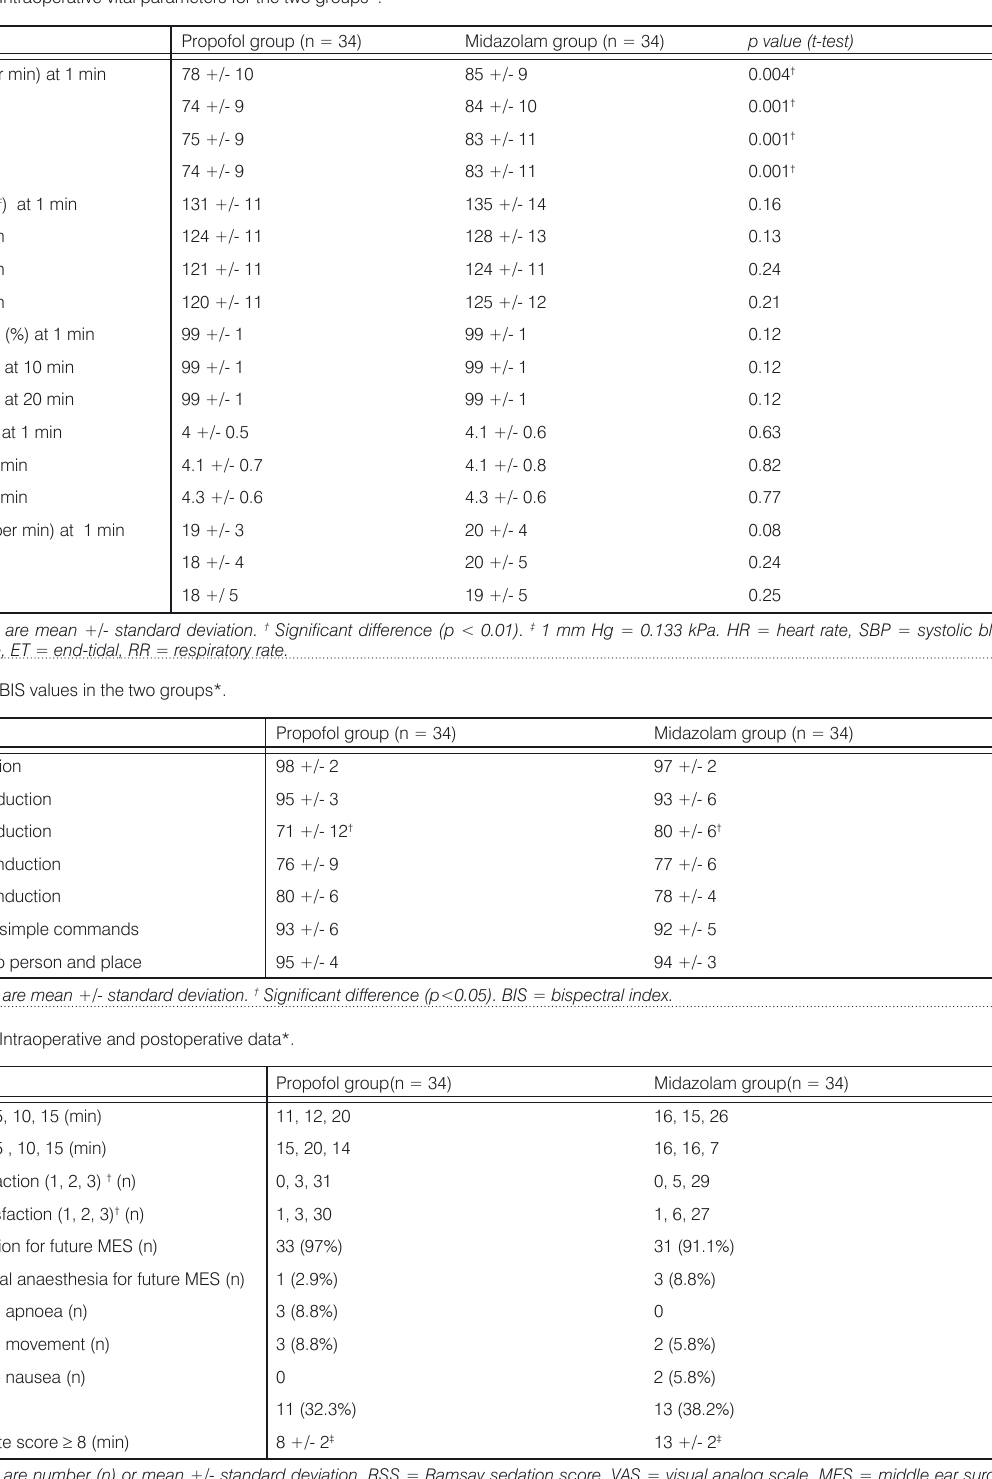
Table 2. Intraoperative vital parameters for the two groups*.